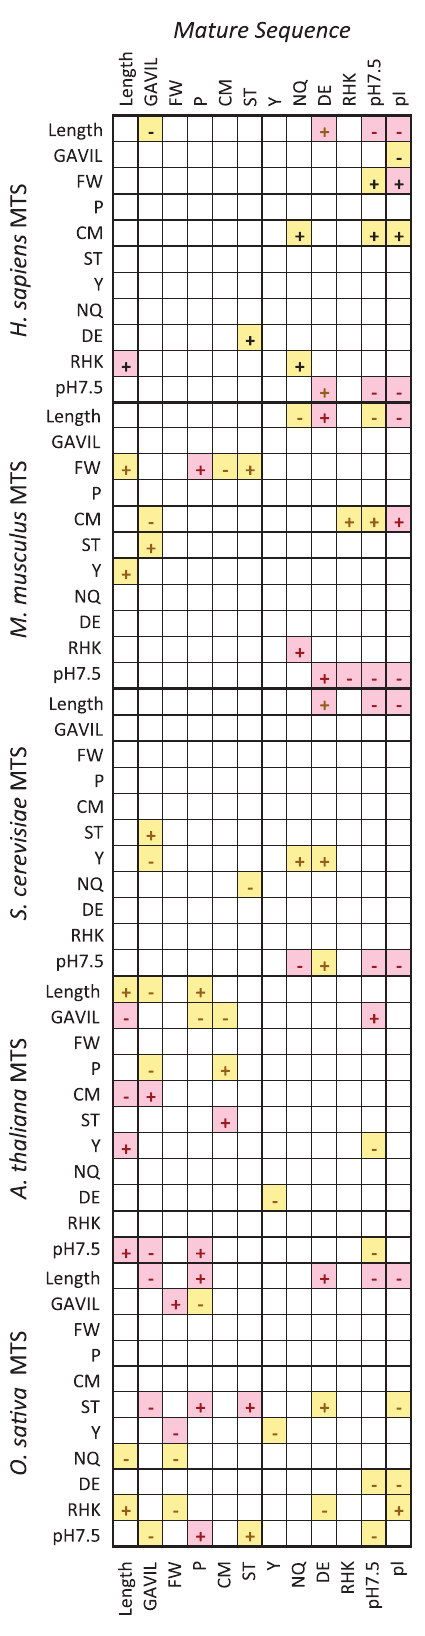
Figure 2. Correlation matrix to analyse pairwise characteristics between MTS and mature sequence. Spearman’s rho